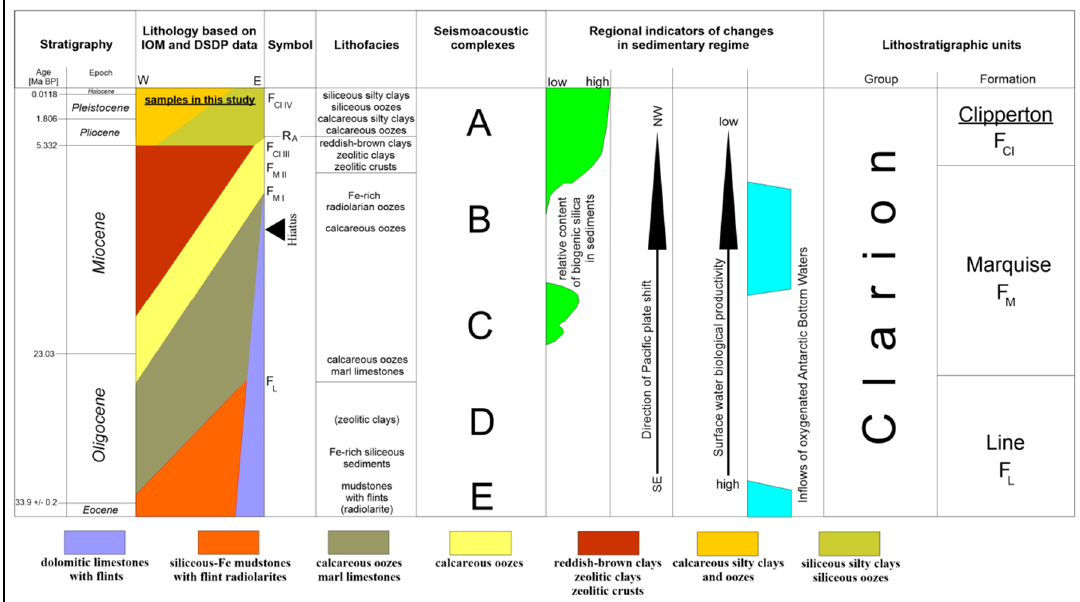
Figure 2. The complex lithostratigraphic scheme of the eastern CCFZ [2,9]. Samples described in the study are classified in the top section of the Clipperton Formation (FCl).